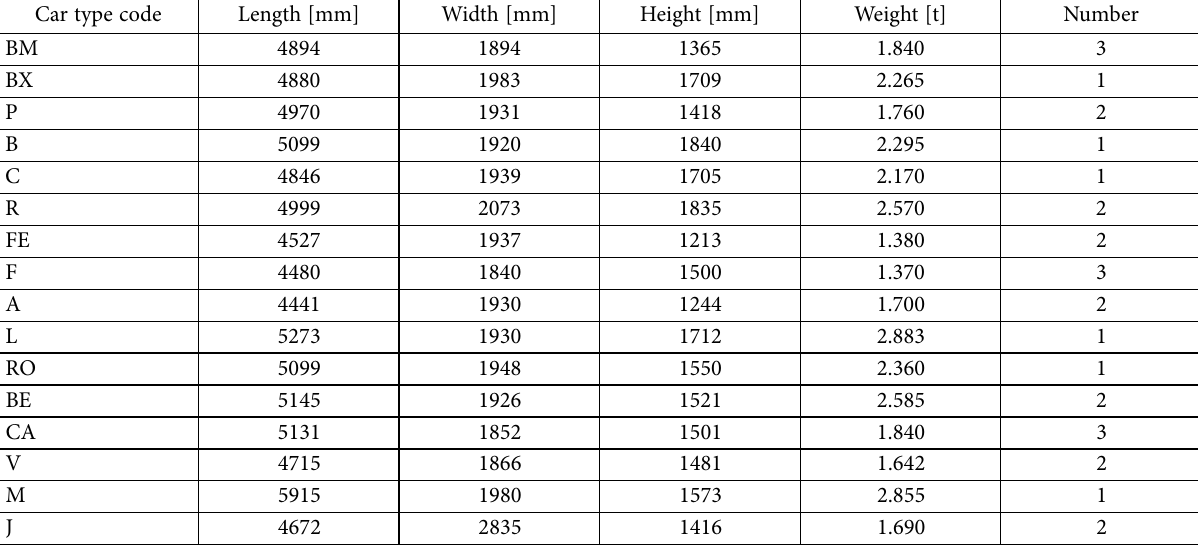
Table 3. Information for the cars need to be transported